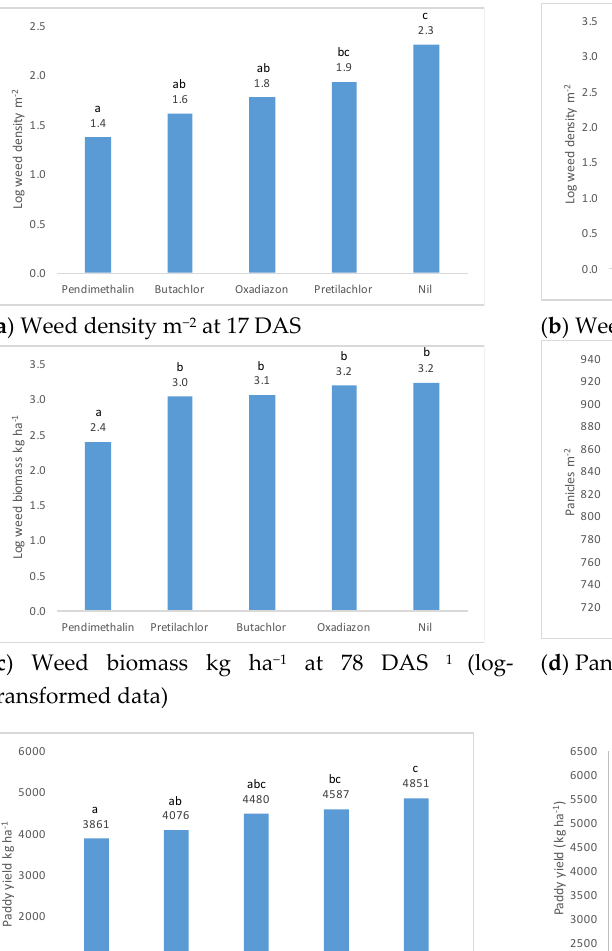
Table 8. Effect of post ‐ emergence herbicide on rice yield components in 2019.